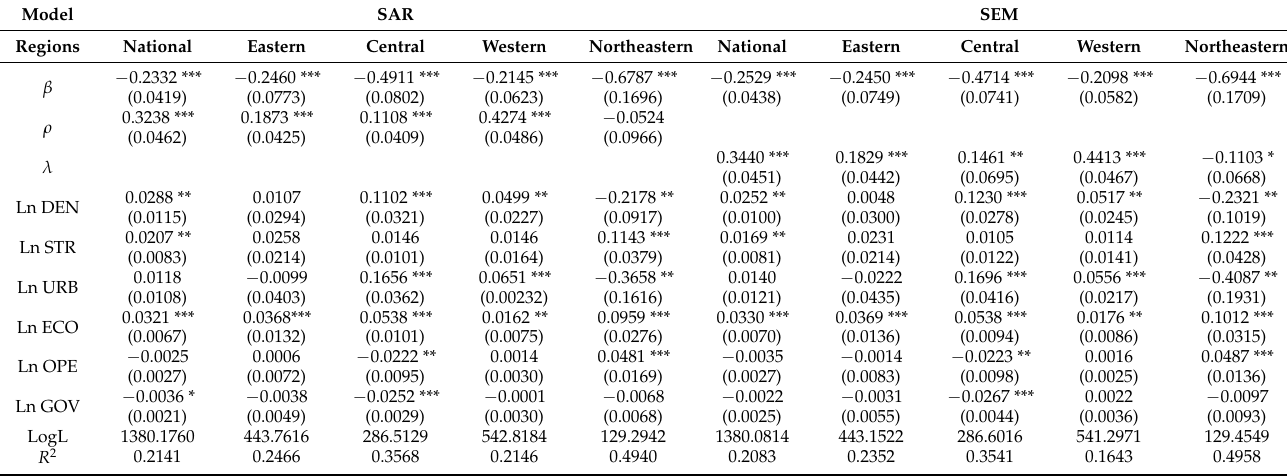
Table 6. Results of conditional β -convergence